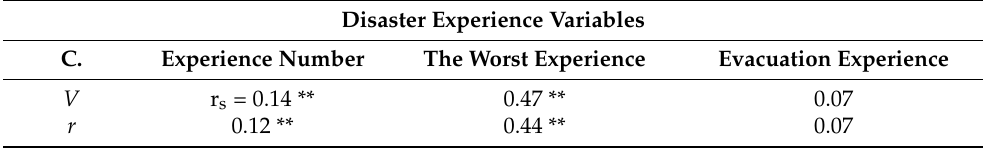
Table 6. Association and correlation between dependent variable and disaster experience variables.